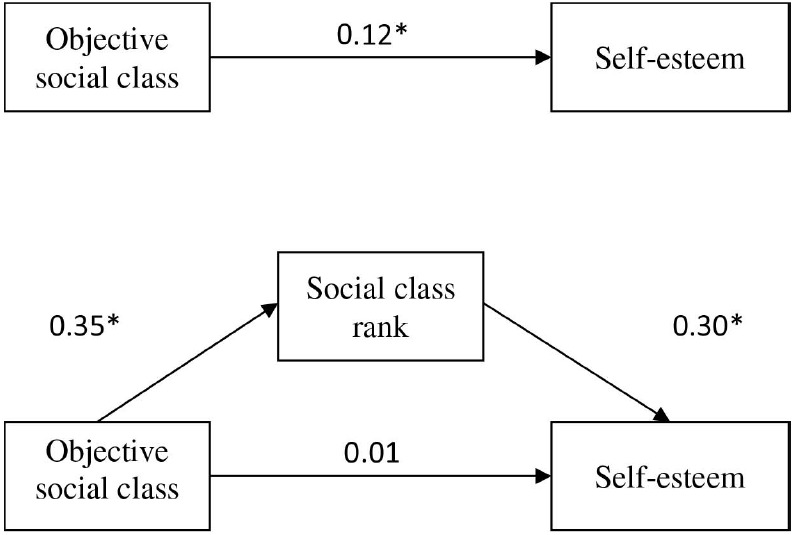
Path analysis showing the relationships between objective social class, perceptions of social class rank, and self-esteem (Study 1). The top panel shows the association between objective social class, measured in terms of a composite of educational attainment and annual income, and self-esteem. The bottom panel shows the association between objective social class and self-esteem, through subjective social class rank. Numbers indicate standardized beta coefficients. *p < 0.05.